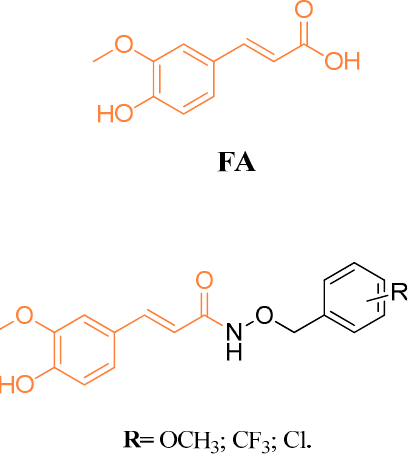
Figure 1. General structures of ferulic acid (FA) and its benzyloxyamidic